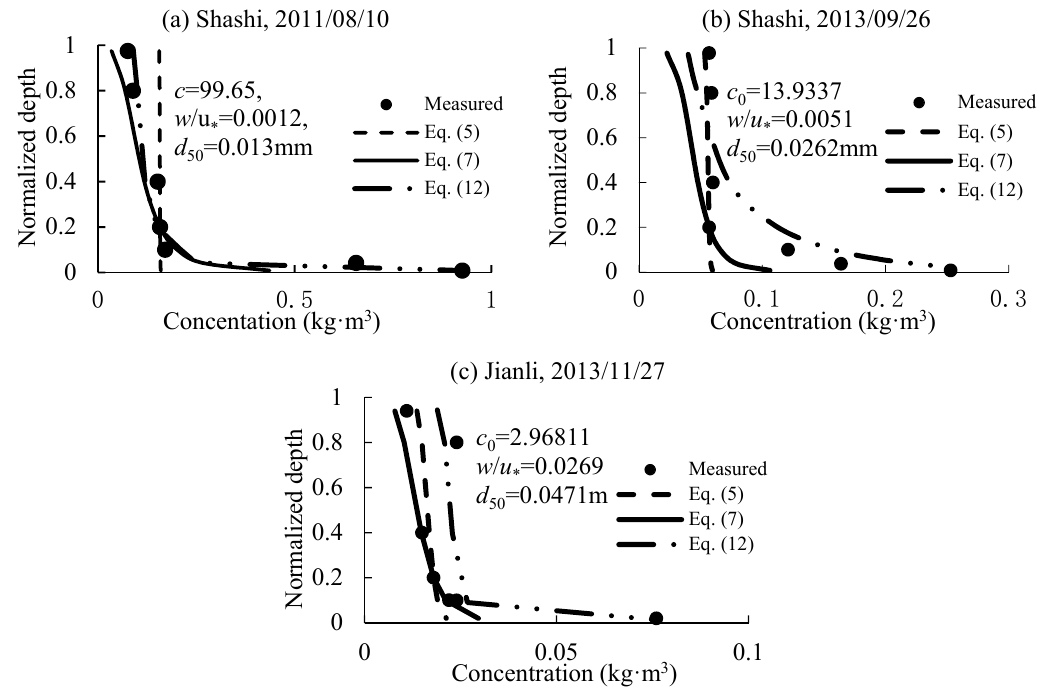
Figure 10. Comparison between measured and calculated vertical profiles of suspended sediment concentration. Data in ( a ) were measured on 10 August 2011 at Shashi station, data in ( b ) were measured on 26 September 2013 at Shashi station, and data in ( c ) were measured on 27 November 2017 at Jianli station.